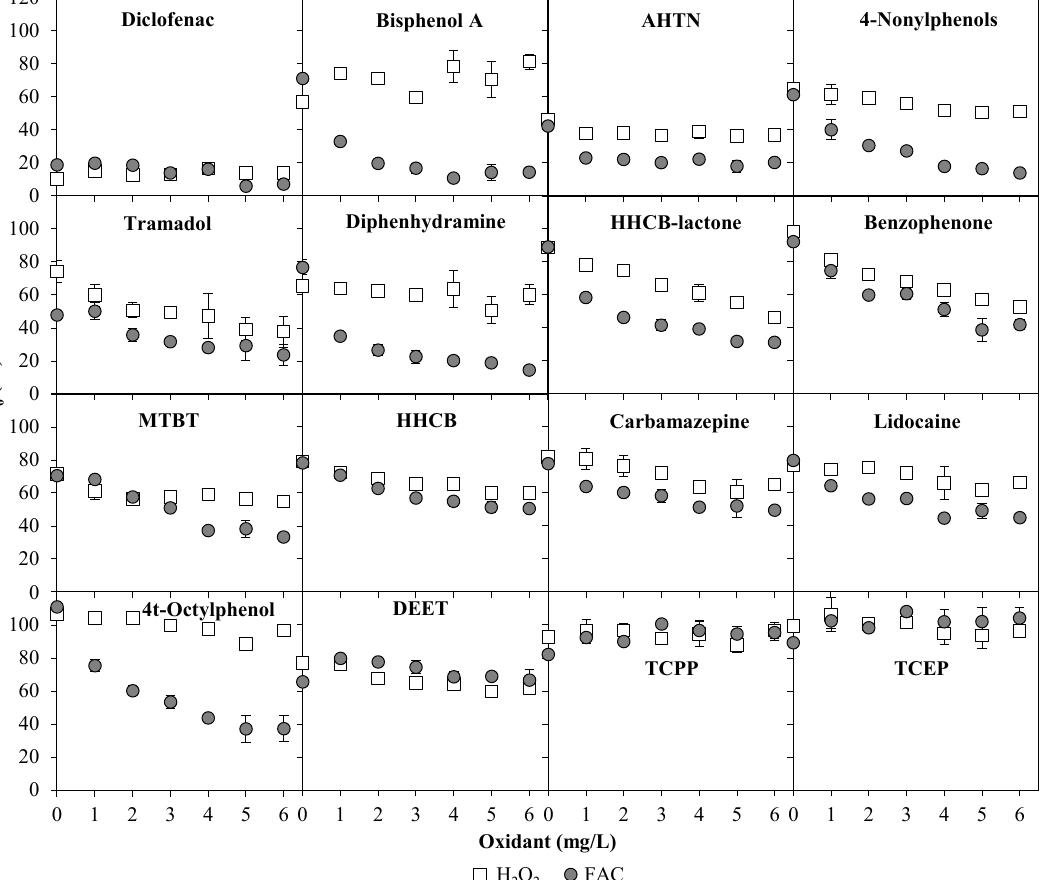
Figure 6. Removal of emerging contaminants found in WWTE by means of UV/chlorine AOP and UV/H 2 O 2 AOP at 0.4 kWh/m 3 UV energy consumption (1 m 3 /h, 0.4 kW) as a function of oxidant concentration (Experiment 2). At 0 mg/L oxidant: sole UV treatment.